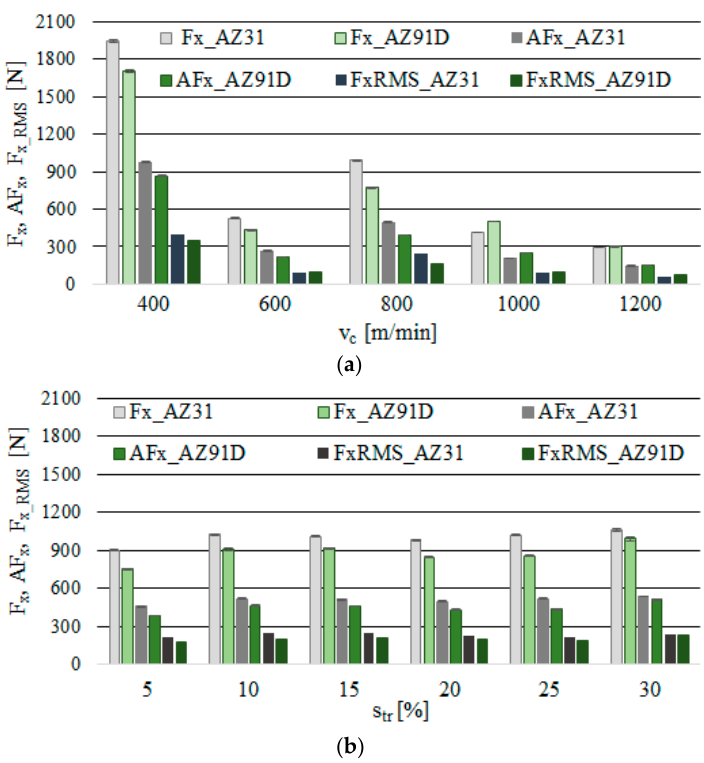
Figure 5. Maximum value of cutting force component F x , amplitude and RMS in the milling of magnesium alloys: ( a ) effect of cutting speed v c (f z = 0.15 mm/tooth, a p = 6 mm, s tr = 15%) and ( b ) effect of trochoidal step s tr (v c = 800 m/min, f z = 0.15 mm/tooth, a p = 6 mm).